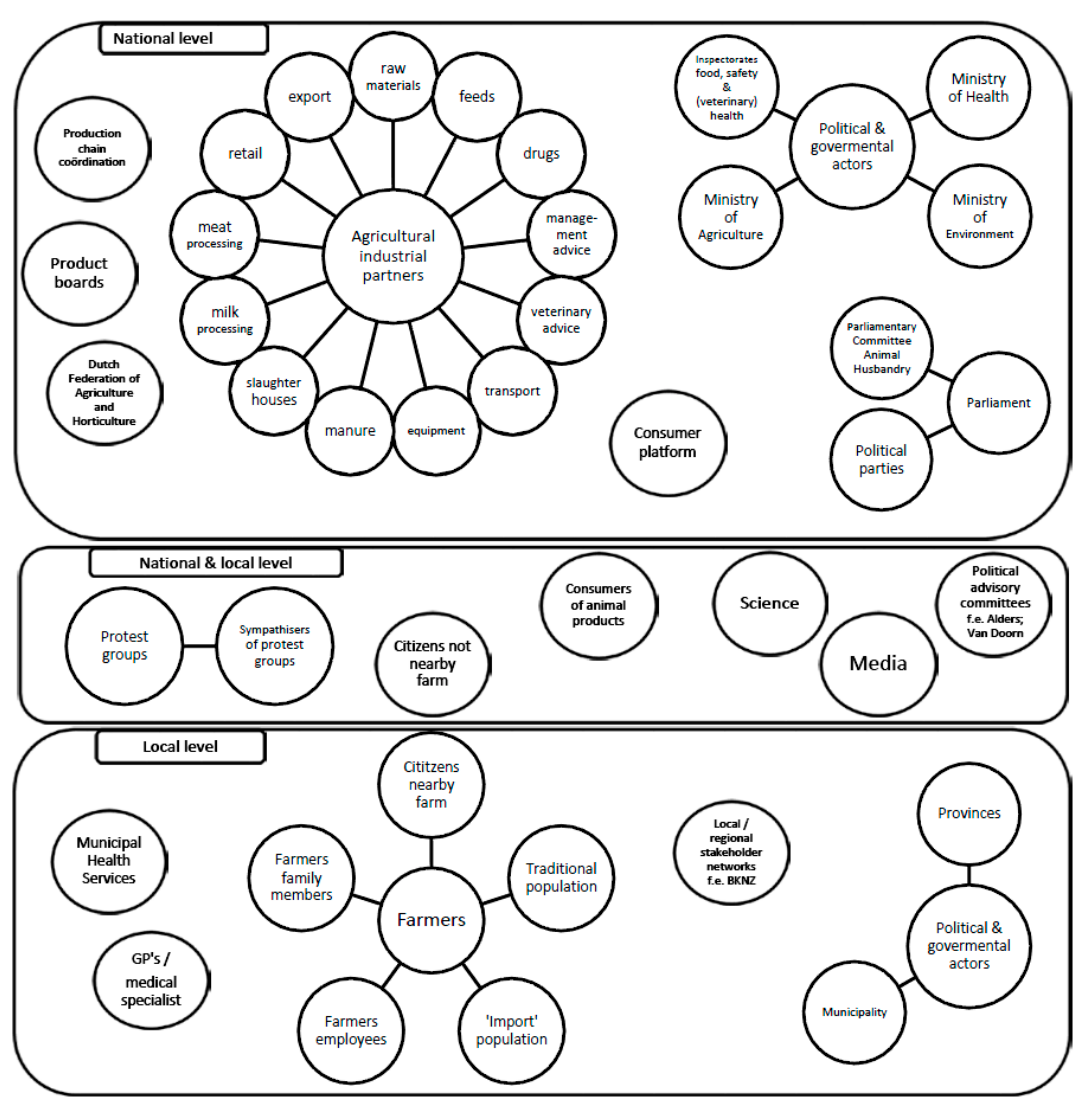
Figure 1. Stakeholders involved in Dutch debate on Intensive Animal Production Systems (IAPS) and health.